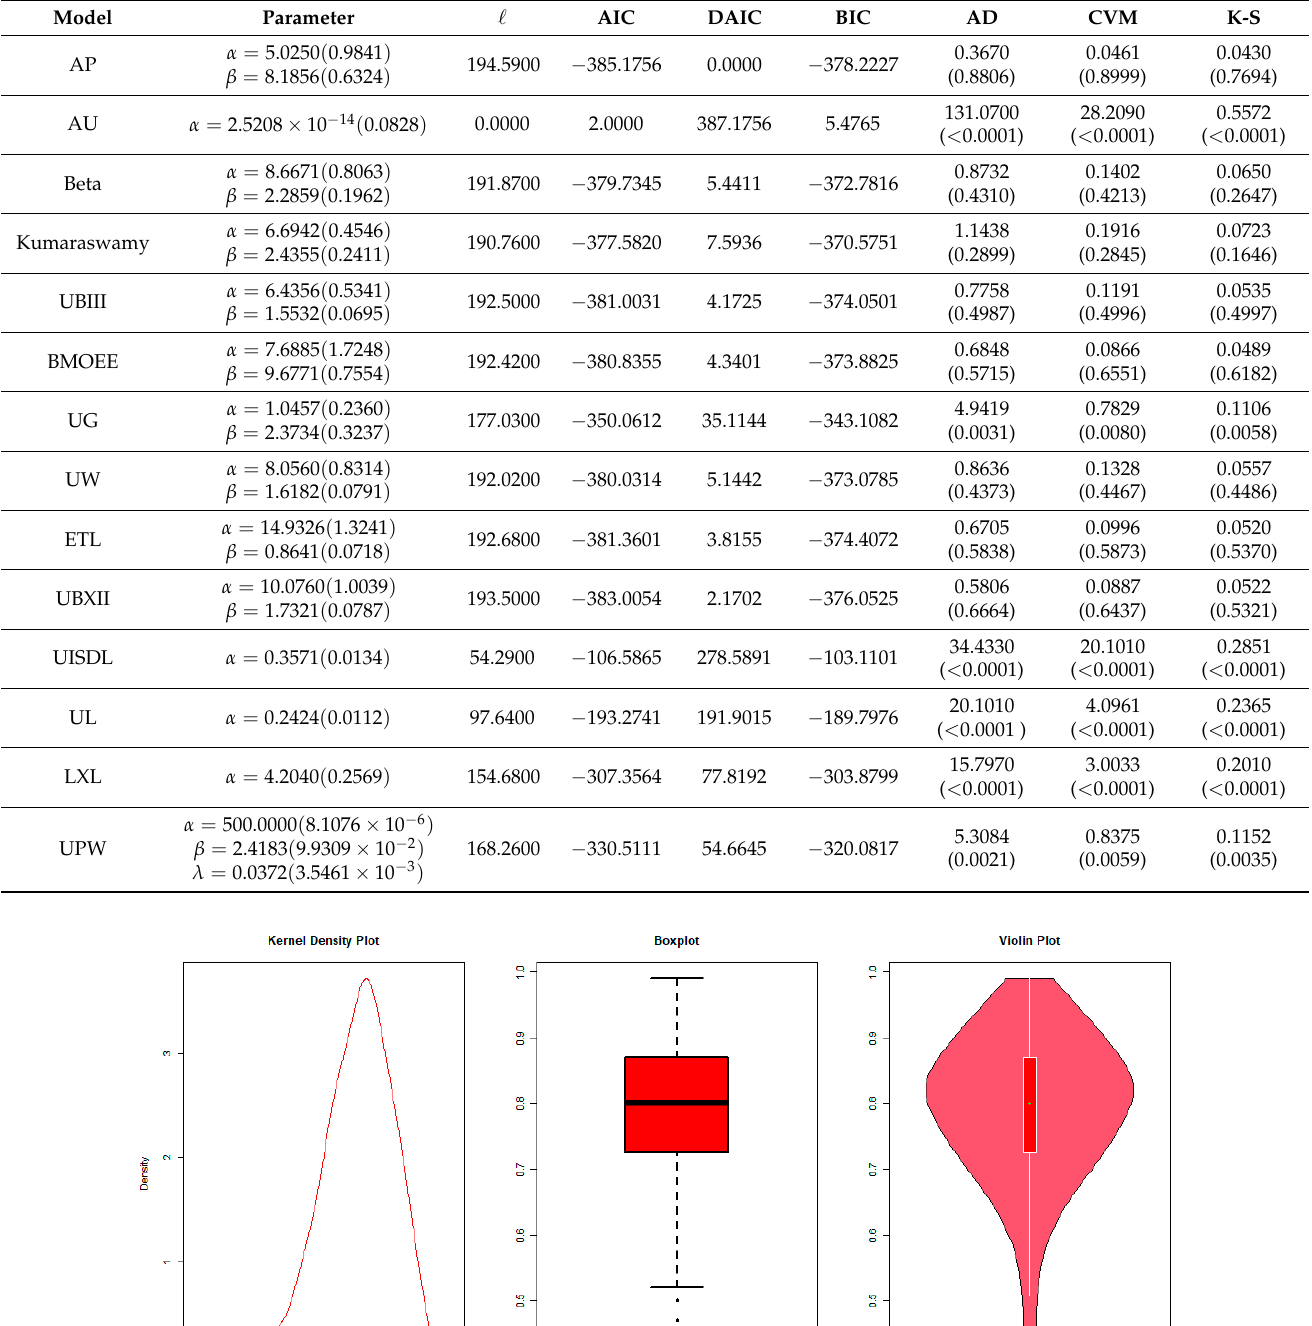
Table 3. Parameter estimates, standard errors, goodness-of-fit tests.